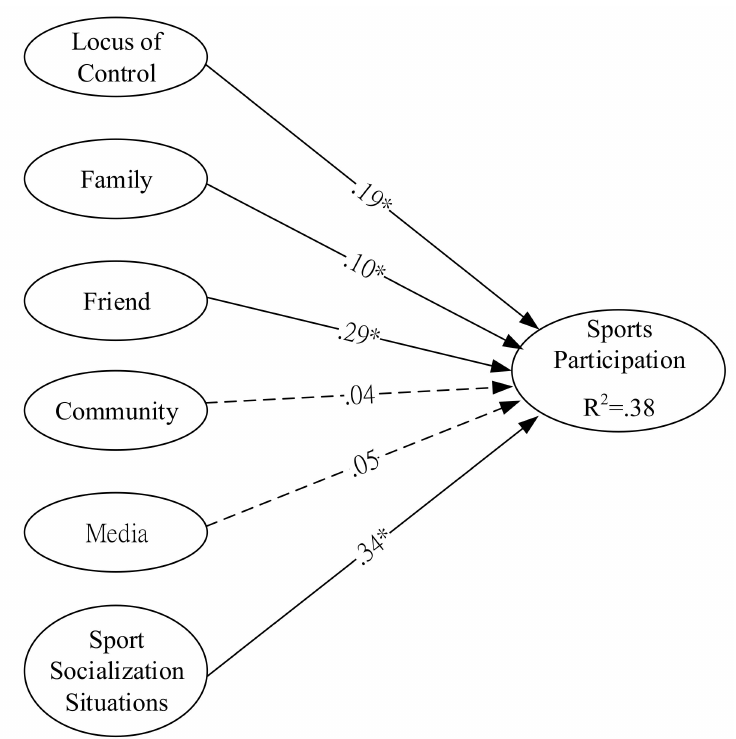
Figure 1. Structural equation modeling (SEM) results of the standardized model parameter estimation. * p < 0.05; solid line: significant; dashed line: